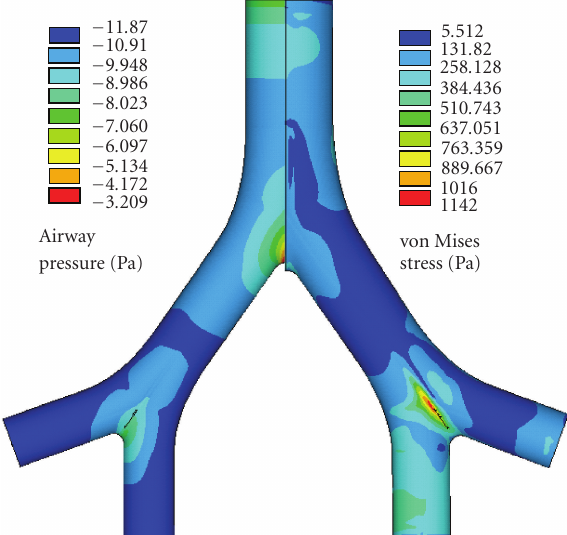
Figure 6: A distribution of the airway pressure and von Mises stress in the airway generations 3 to 5 for the orthotropic flexible model during the peak inhalation.